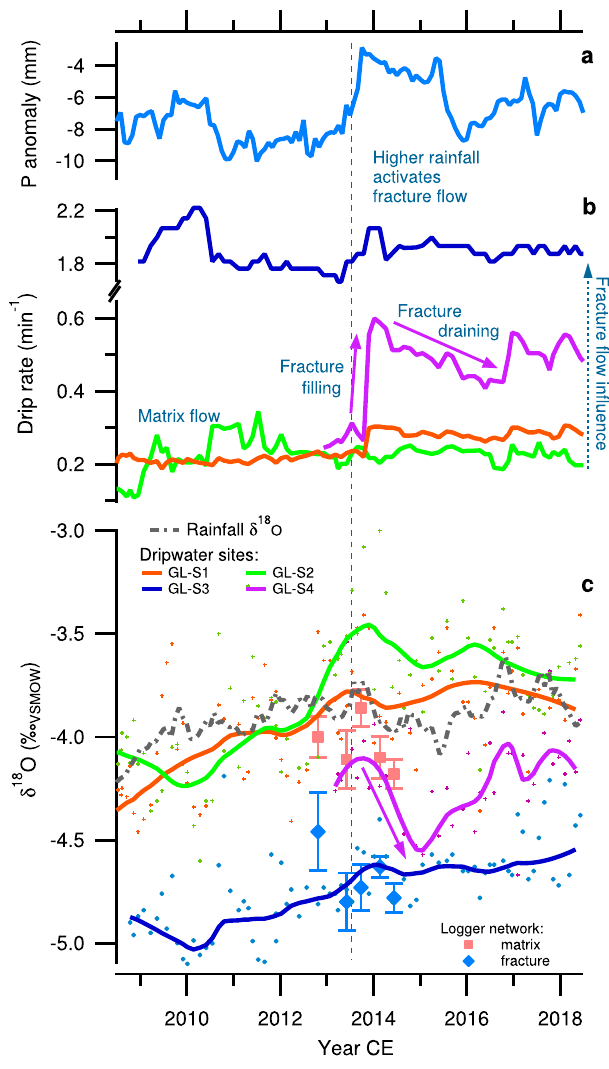
Fig. 5 Golgotha Cave monitoring data. a Smoothed monthly meteoric precipitation (P) anomalies (cerulean blue). b Monitored drip rates for speleothem sites GL-S1 (red), GL-S2 (green), GL-S3 (navy blue) and GL- S4 (purple). c Smoothed precipitation-weighted monthly rainfall δ 18 O (grey dash) and smoothed dripwater δ 18 O for drip sites where speleothems were collected (colours as for drip rates); mean δ 18 O values of matrix (orange squares) and fracture fl ow sites (blue diamonds) in the drip logger array sampled during fi ve fi eld campaigns. Error bars represent ±1 σ of measurements from multiple sites. Monthly precipitation anomalies were calculated using the monthly climatological means from 1950 to 2020. An exponentially-weighted moving average (EWMA) was applied to monthly P anomalies with a half-life parameter of 36.6 months; similarly an EWMA was applied to monthly rainfall δ 18 O using a 25 month half-life, as well as a lag of 19 months supported by our fi eld studies in refs. 40,51 . Dripwater δ 18 O were smoothed with a loess 2nd order fi lter (span 0.3). Drip rates exhibit a threshold response to higher in fi ltration indicating the relative in fl uence of fractures on each fl owpath 40 . For example, the drip for GL-S4 rapidly increases in response to higher precipitation anomalies during 2013 compared to the much smaller rise in the drip rate for GL-S1, indicating that a larger fracture component is feeding GL-S4. Over the same period, mean drip rate of the logger array increased from 0.16±0.02 to 0.20±0.40 for matrix fl ow sites and from 2.21 ±0.40 to 8.32 ±3.43 for fracture fl ow sites. The relative contribution of fracture fl ow to each drip site is inversely related to drip δ 18 O values with activation of fractures occurring during periods of higher in fi ltration associated with lower rainfall δ 18 O